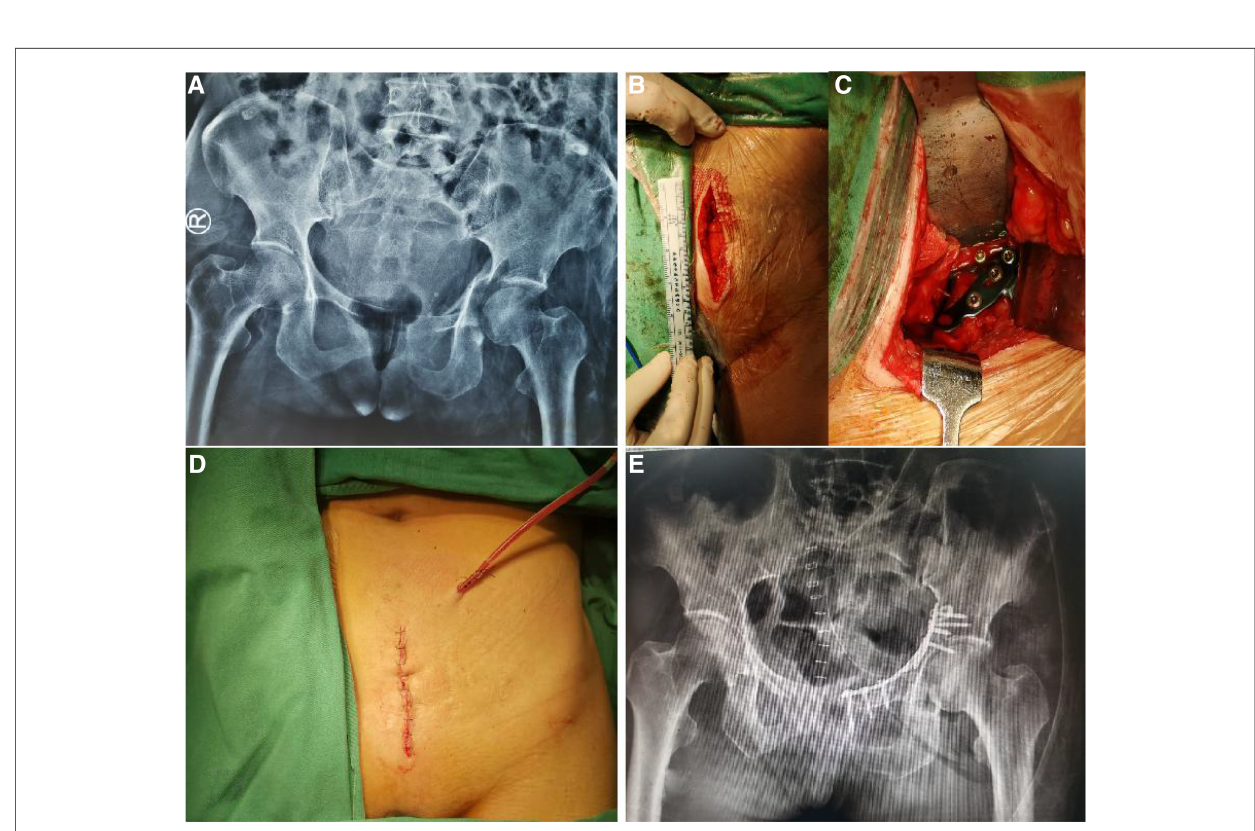
FIGURE 2 A female patient, 57 years old, with a T-type acetabular fracture who underwent surgical treatment via a modi fi ed stoppa approach. ( A ) preoperative anteroposterior pelvic radiograph; ( B ), picture of the incision of the modi fi ed Stoppa approach; ( C ), internal fi xation was placed after fracture reduction; ( D ), a CSD was used after surgery; ( E ), postoperative anteroposterior pelvic